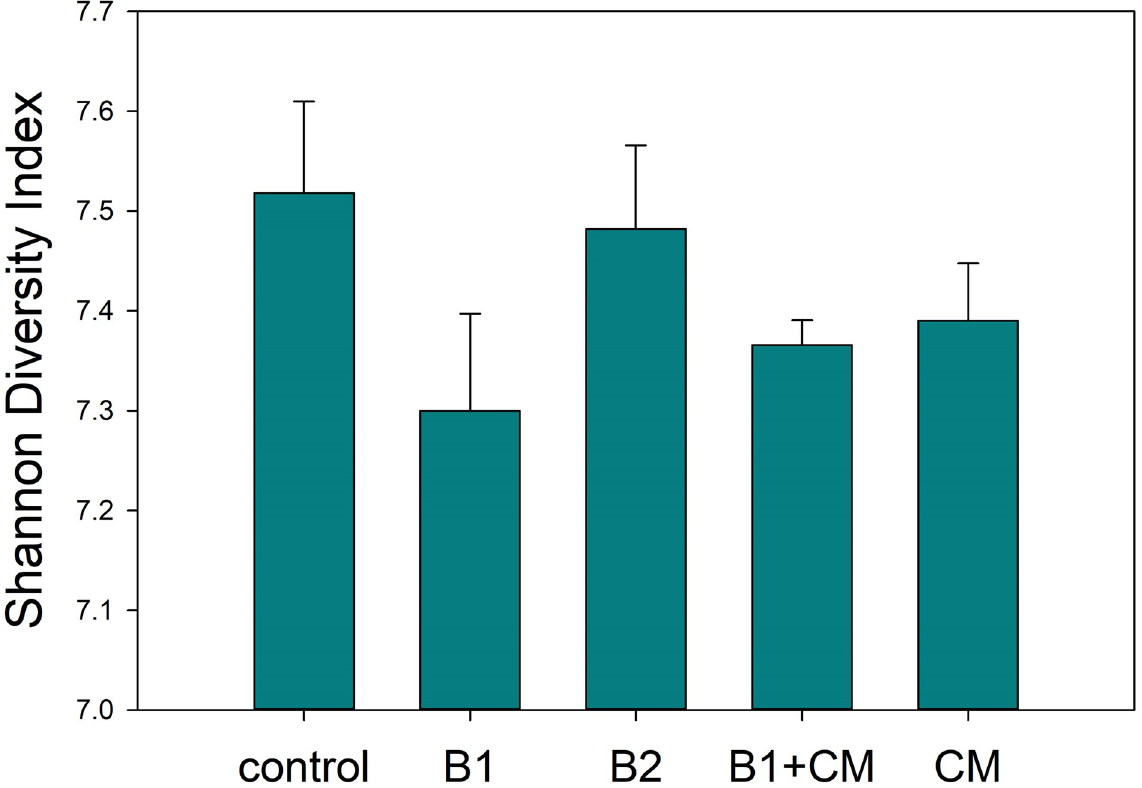
Fig 2. Bacterial/ archaeal community α -diversity based on Shannon indices indicated that the low biochar treatment (B1) significantly reduced community diversity compared to the control (Holm-Sidak, P < 0.05). Treatments include unamended control (CK), 12.5 t ha -1 biochar (B1), 25 t ha -1 biochar (B2), 5 centimeter (cm) green waste compost (CM), and 12.5 t ha -1 biochar and 5 cm compost